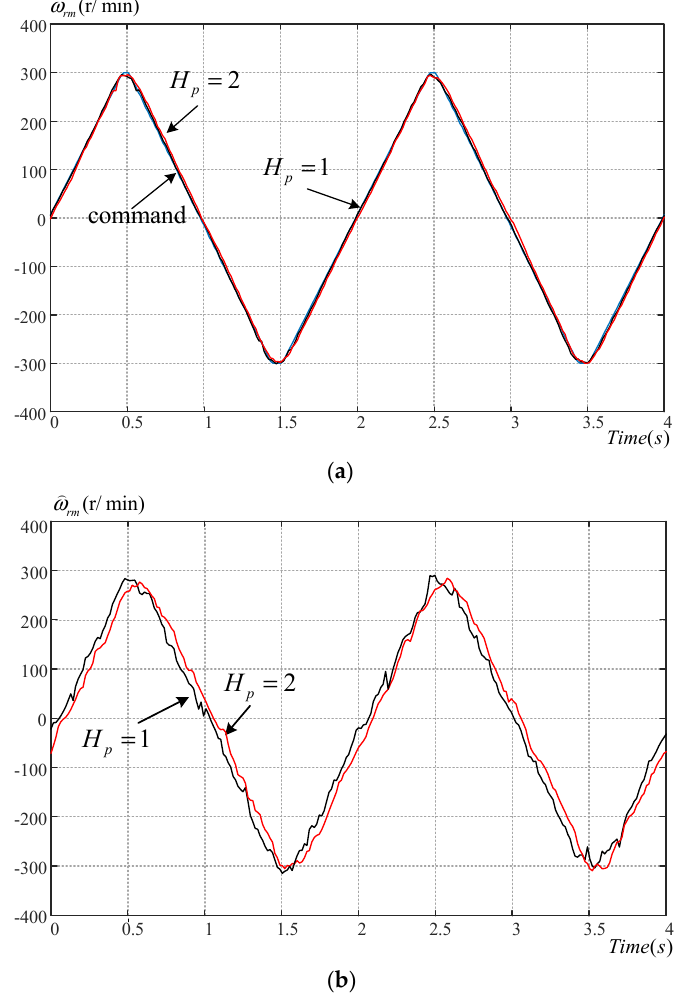
Figure 15. Measured triangular speed tracking responses. ( a ) Using an encoder and ( b ) using the proposed senseless method.